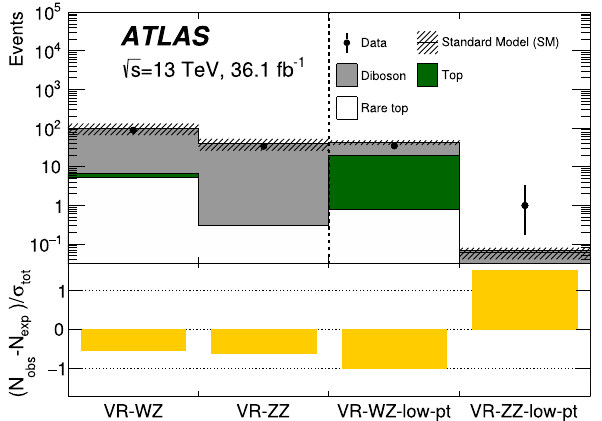
Fig. 7 Validation of the data-driven fake-lepton background for the low- p T analysis. The m (cid:4)(cid:4) distribution in VR-fakes (left) and VR-SS (right). Processes with two prompt leptons are modelled using MC simulation. The hatched band indicates the total systematic and statistical uncertainty of the background prediction. The last bin always contains the overflow